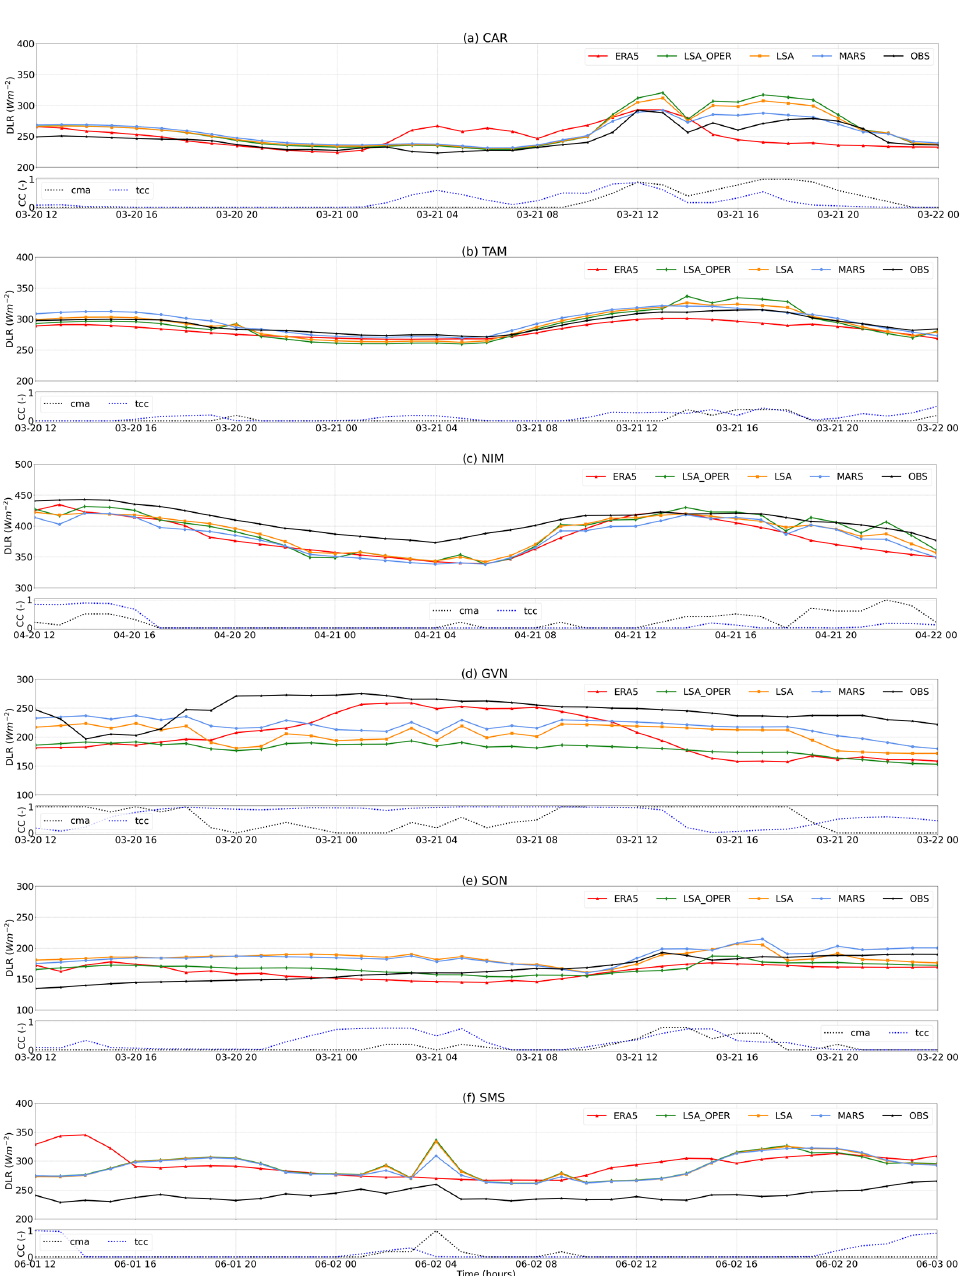
Figure 4. DLR (W · m − 2 ) hourly time-series for different ground measuring stations: CAR ( a ), TAM ( b ), NIM ( c ), GVN ( d ), SON ( e ), and SMS ( f ). The study focusses a 36 h-window between 12 and 00 UTC for each station for different periods. Different models are shown: MARS (in blue), LSA (in orange), LSA_OPER (in green), and ERA5 (in red); together with in situ observations (in black). Hourly cloud cover (CC) information is also added in the inside plots with the total cloud cover ( tcc ) from the ERA5 (blue dots) and the cloud fraction ( cf ) from the MSG (black dots).